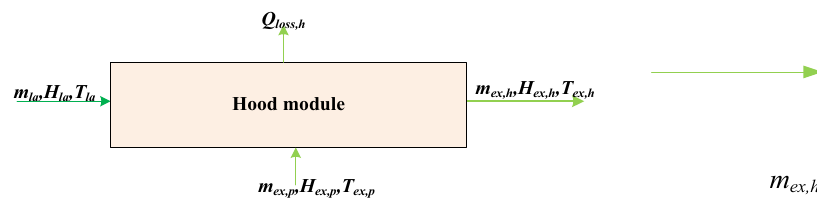
Fig. 5 Modular diagram of heat recovery